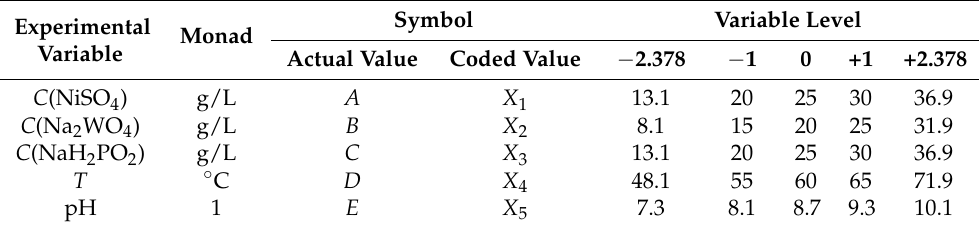
Table 2. Five-factor, five-level response surface test design and